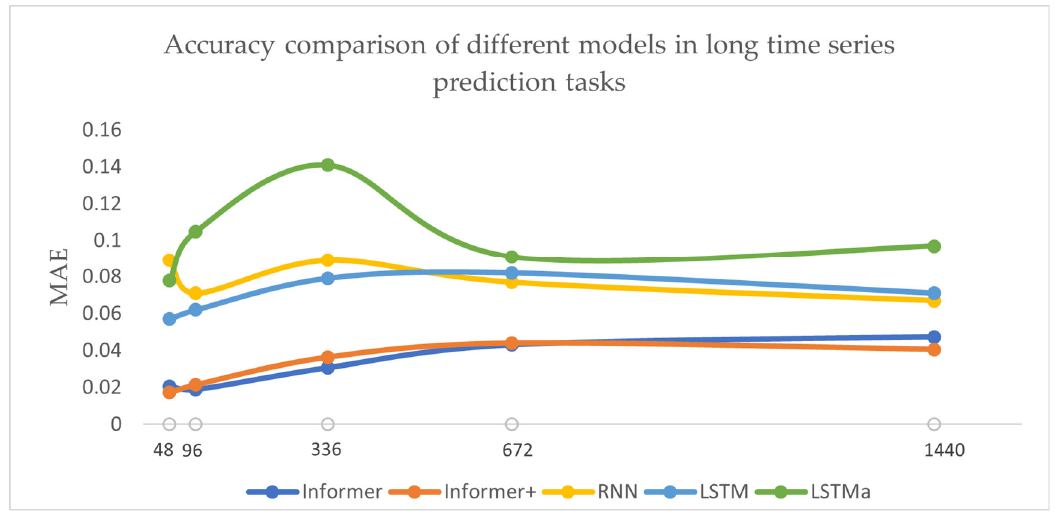
Figure 9. Accuracy comparison of five models in power-load forecasting.